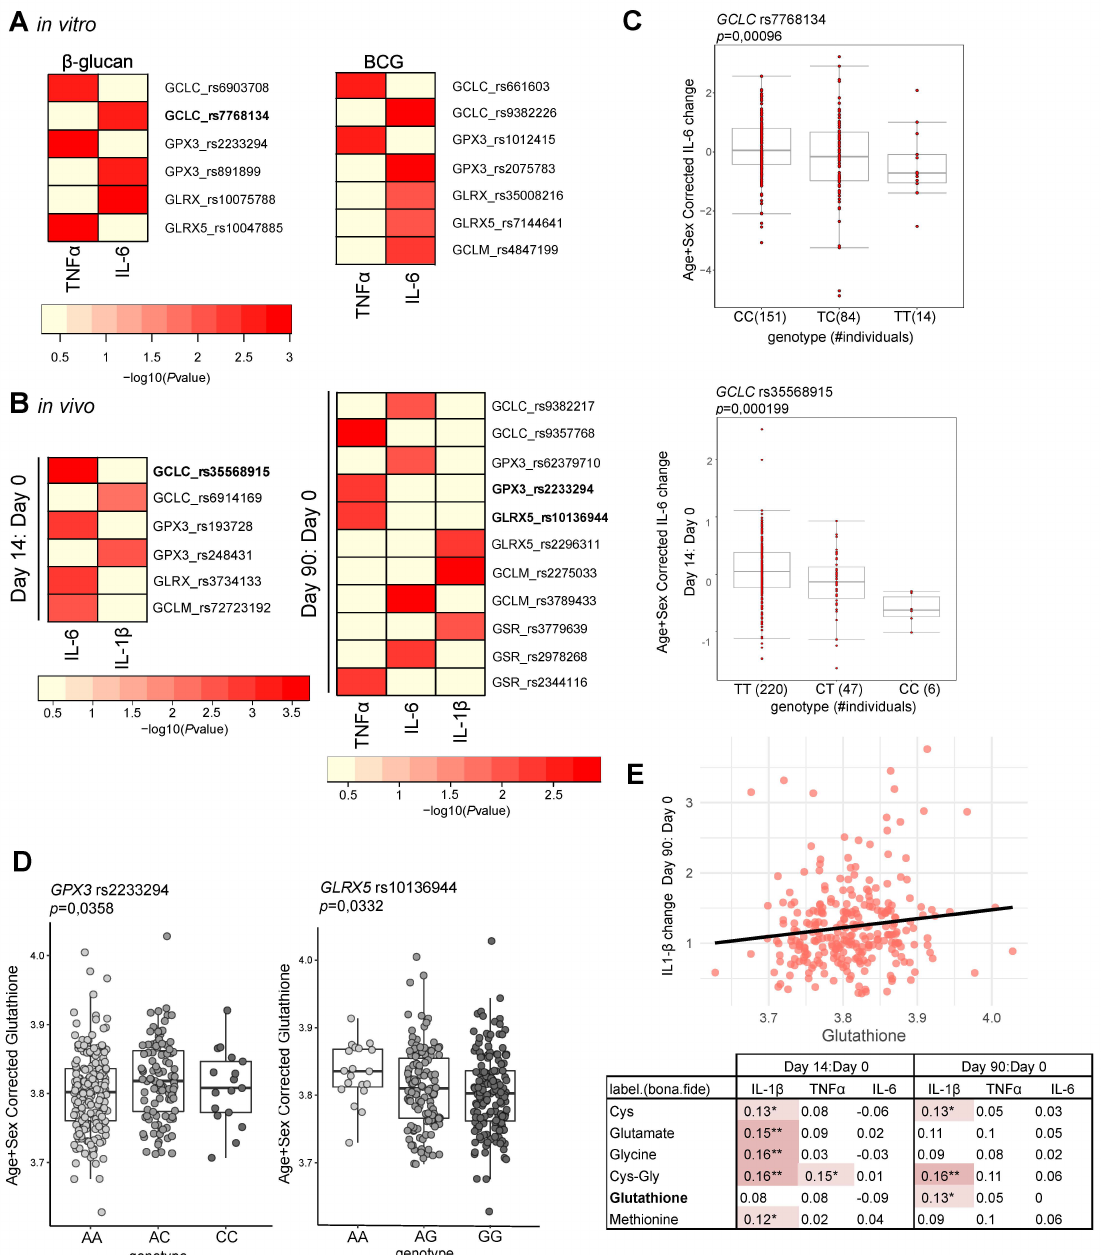
Figure 3. Glutathione is associated with trained immunity features. Heatmap of the p -values of association ( p < 9.99 × 10 − 3 ) between SNPs mapped to genes involved in glutathione metabolism and the magnitude of cytokine production capacity by monocytes trained in vitro with ( A ) β -glucan and BCG ( n = 251 healthy volunteers for IL-6 and n = 238 healthy volunteers for TNF α ) and ( B ) in vivo BCG training responses ( n = 278 healthy volunteers). ( C ) Boxplot of the lowest p -value SNP per analysis (rs7768134, rs35568915). ( D ) Boxplots showing glutathione plasma levels (corrected for age and sex) stratified by genotype for rs2233294 ( GPX3 ) and rs10136944 ( GLRX5 , n = 302). The p -value for each SNP is derived from linear regression model with the SNP of interest as independent variable and glutathione (corrected for age and sex) as the dependent variable. ( E ) Spearman correlations between circulating metabolites at baseline involved in glutathione metabolism versus fold changes of PBMC-derived S. aureus -induced IL-6, IL-1 β , and TNF α responses measured at 14 or 90 days after BCG vaccination compared to baseline ( n = 297 healthy volunteers). The table presents the Spearman’s rho for each correlation, and the correlations in red highlight significant positive correlations (* p < 0.05, ** p < 0.01). The correlation between glutathione concentration and the fold change of IL-1 β production at 90 days compared to day 0 is given as an example in a scatter